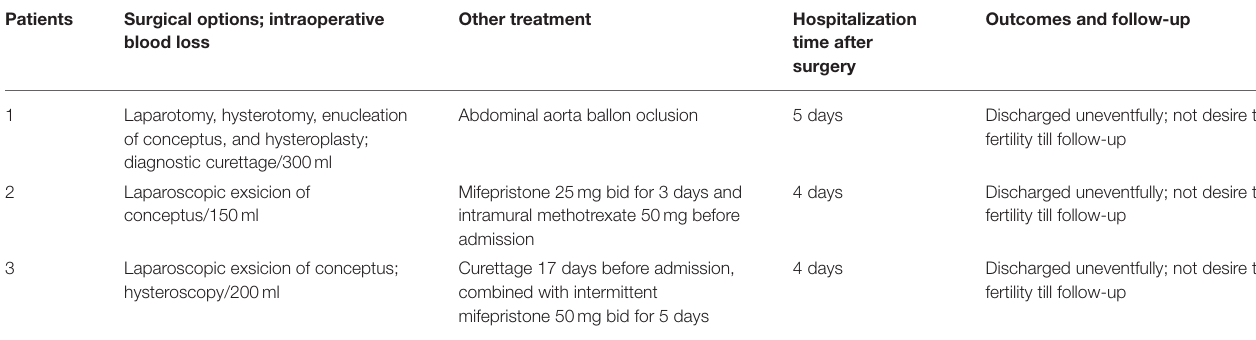
TABLE 2 | Surgical treatment, postoperative recovery, and fertility outcomes of patients with intramural ectopic pregnancy in our hospital.